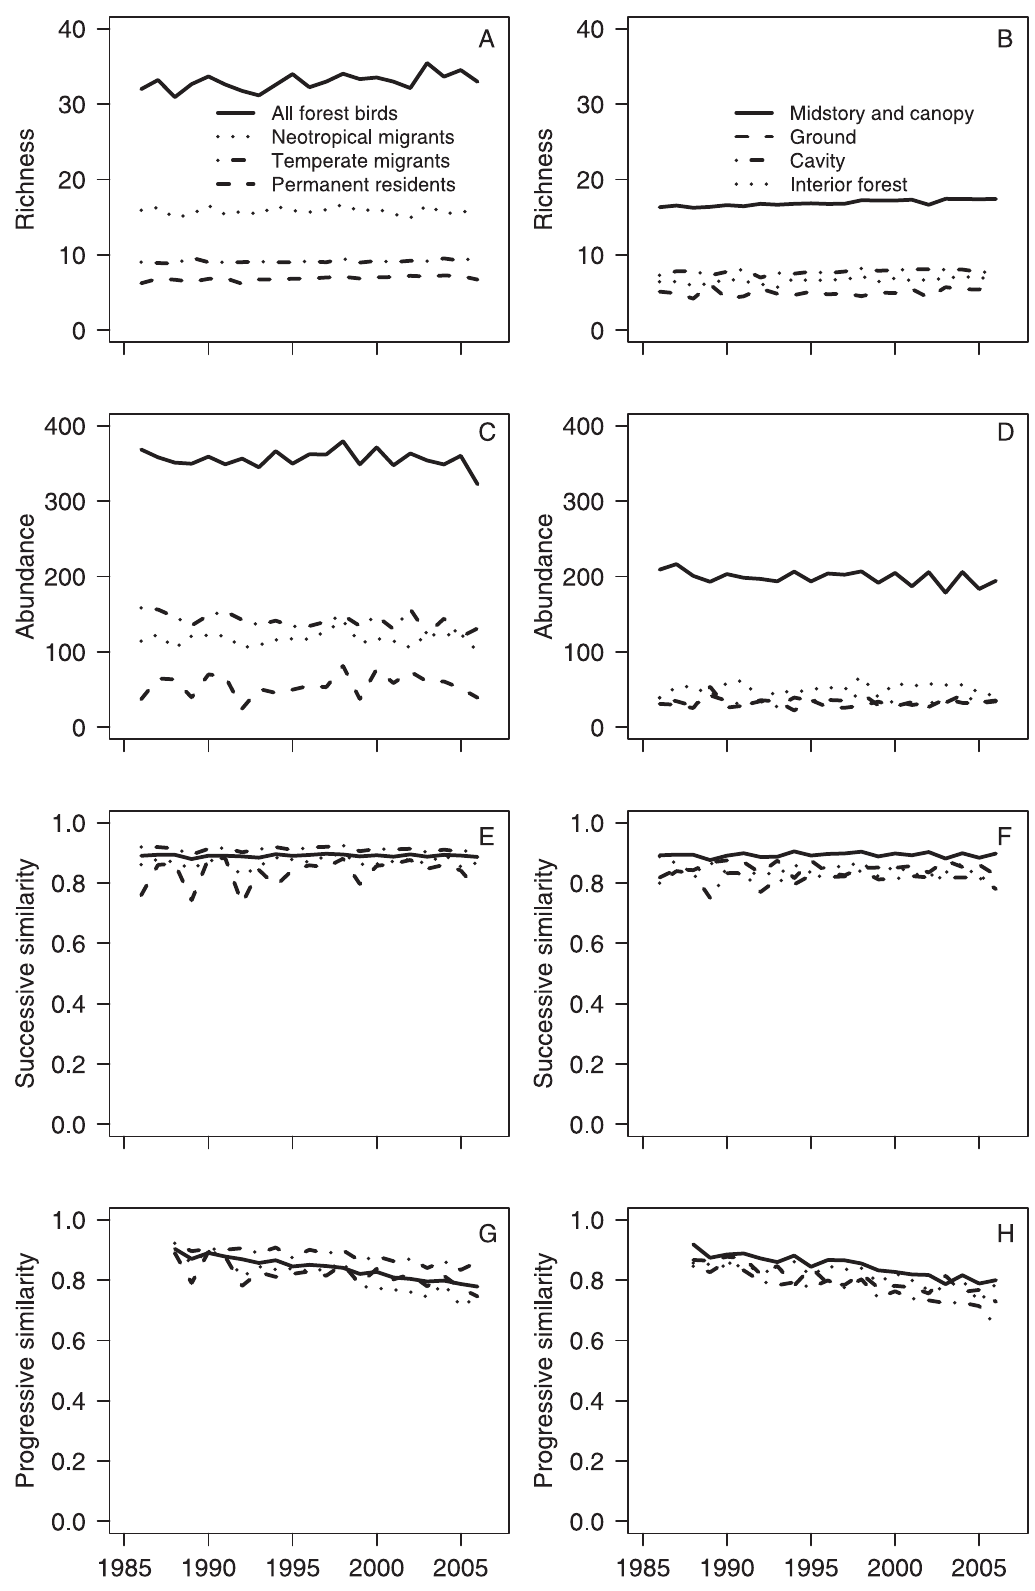
Figure 2. Changes in forest bird community structure by migratory habit (left column) and nest location (right column). Progressive change in community similarity values compares proportional abundance of species for each route and year to the route’s baseline forest bird community (1985–1987).